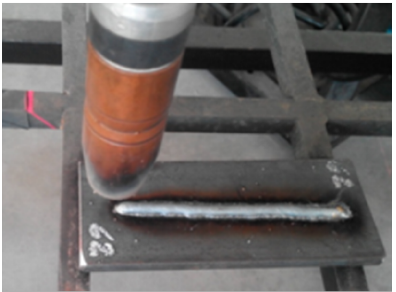
Figure 3. Metal plate with weld bead